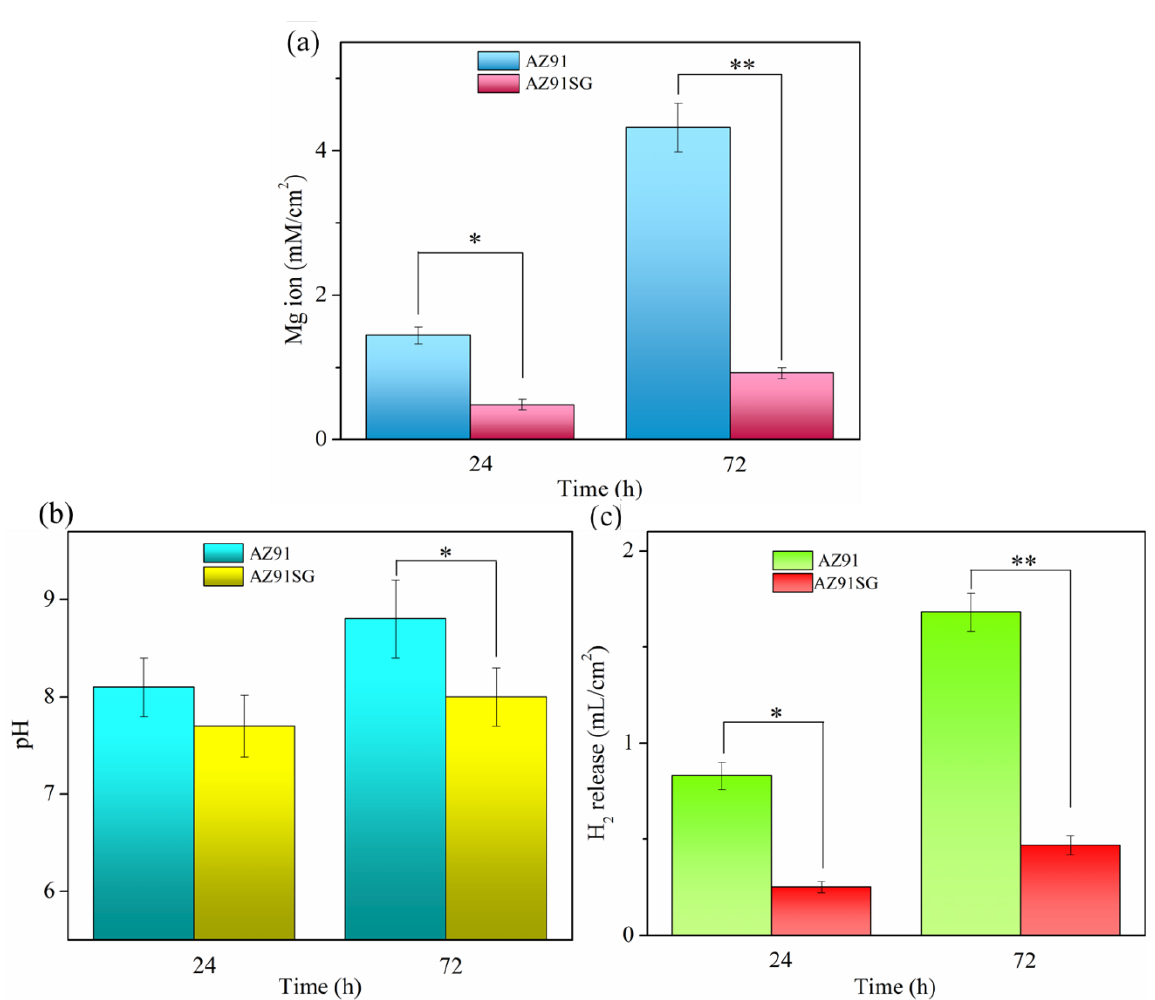
Figure 6. ( a ) Released Mg ions from ICP-OES measurement, ( b ) pH changes and ( c ) rates of H 2 release from AZ91SG with AZ91 as a control group over a period of 24 and 72 h, respectively.